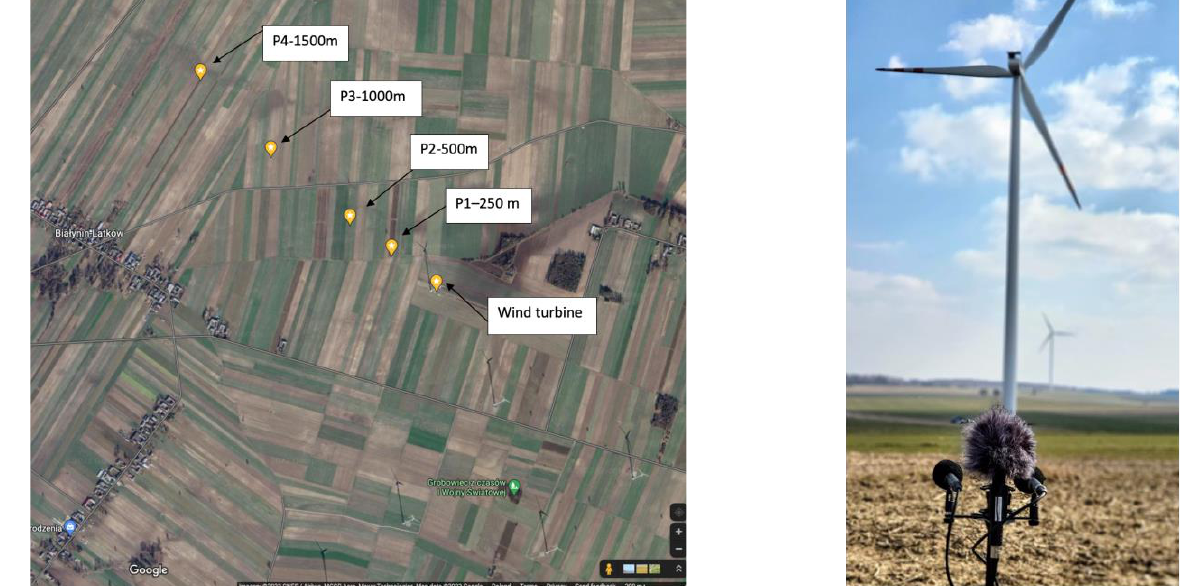
Figure 1. The wind turbine noise measurement and recording points. Satellite photo source: google.maps.com (accessed on 23 June 2022) .